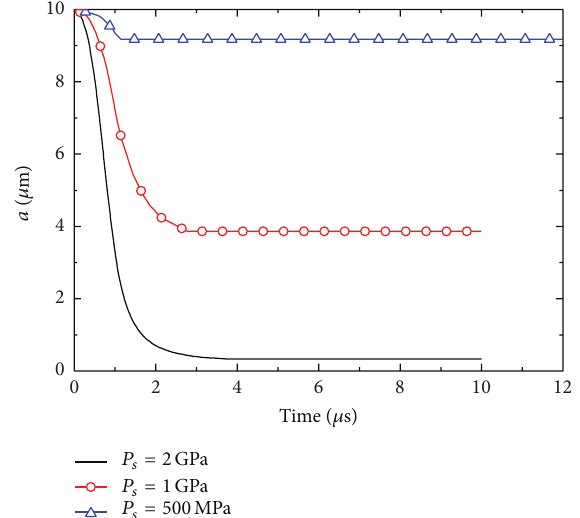
Table 1: Material parameters for